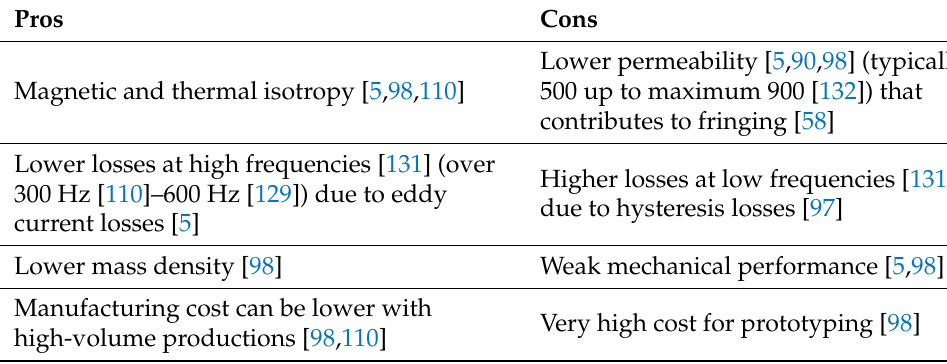
Table 6. Several pros and cons of SMC versus iron